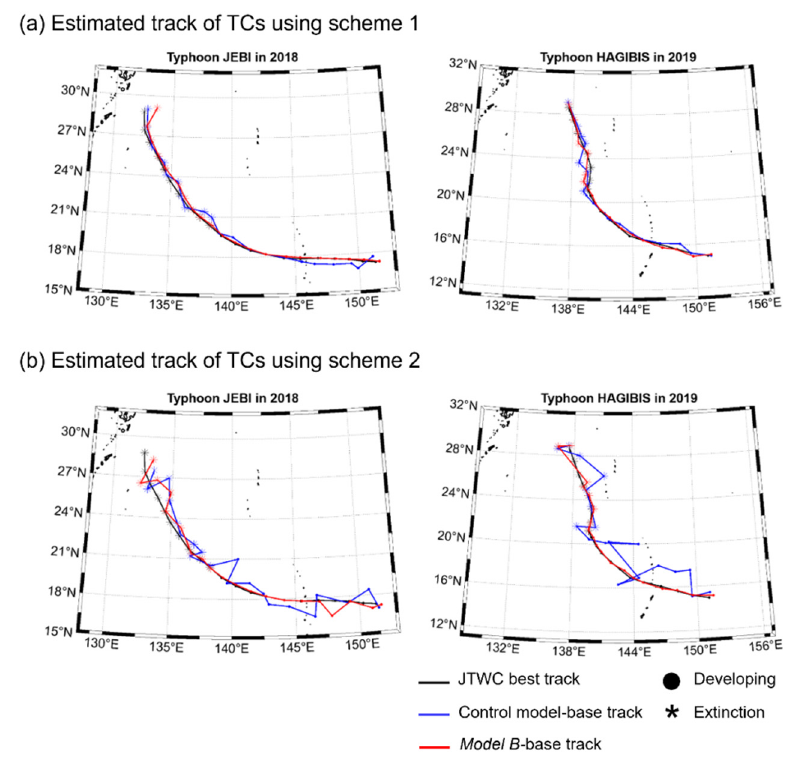
Figure 7. Tracking results of the control model and model B based on two schemes for typhoon JEBI in 2018 and typhoon HAGIBIS in 2019. ( a , b ) show the tracking results according to schemes 1 and 2 , respectively. The black, blue, and red lines indicate the JTWC best track, the estimated track by the control model, and the estimated center by model B , respectively. A filled circle represents a tropical cyclone in the developing phase, while an asterisk indicates a tropical cyclone in the decaying phase.